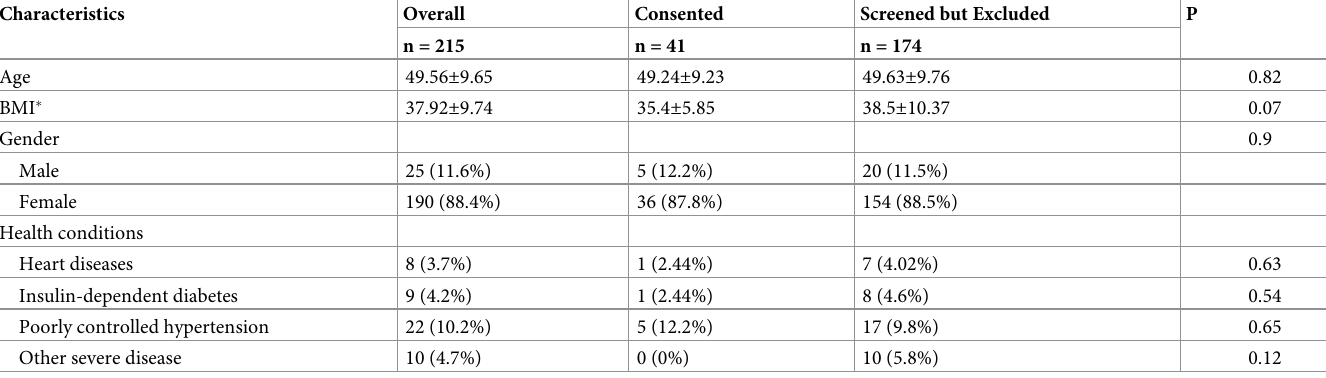
Table 1. Characteristics of individuals who completed the online screening survey, overall and those who were consented to the study vs. those were screened but excluded from the study.